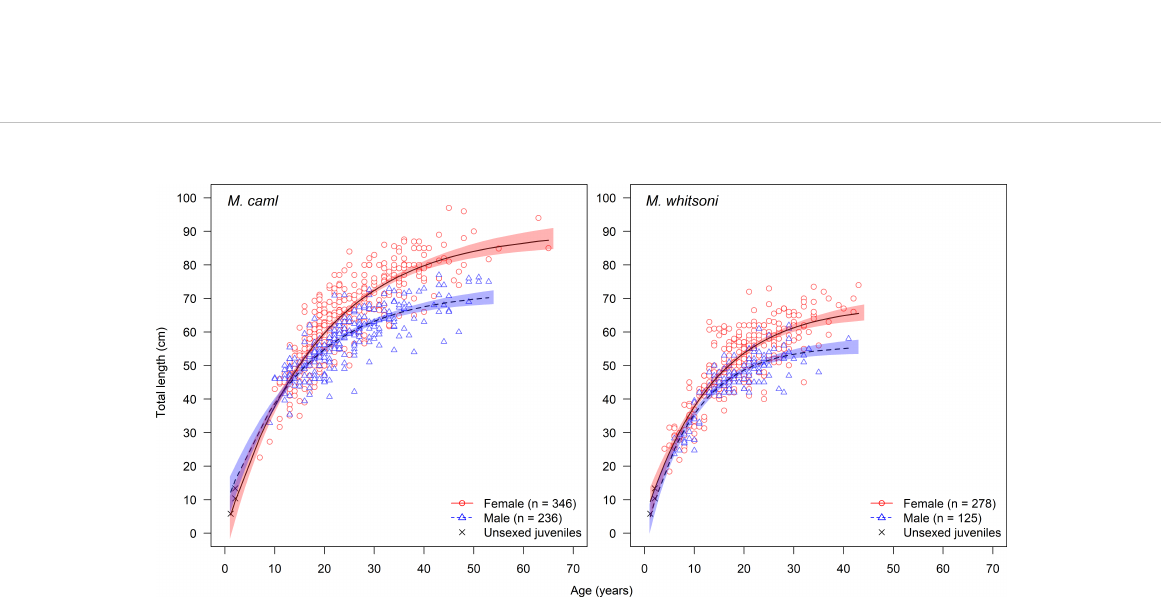
FIGURE 6 Length-at-age data and fi tted unconstrained von Bertalanffy growth curves for female and male Macrourus caml (left) and M. whitsoni (right) in the Ross Sea region. Shaded areas indicate 95% con fi dence intervals. Total sample sizes for each sex are indicated in